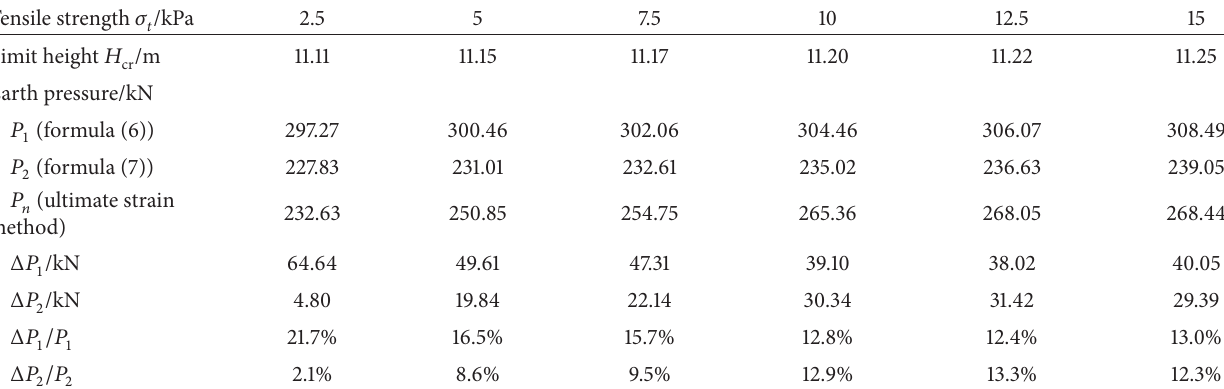
Table 6: Limit height and active earth pressure under the condition of different tensile